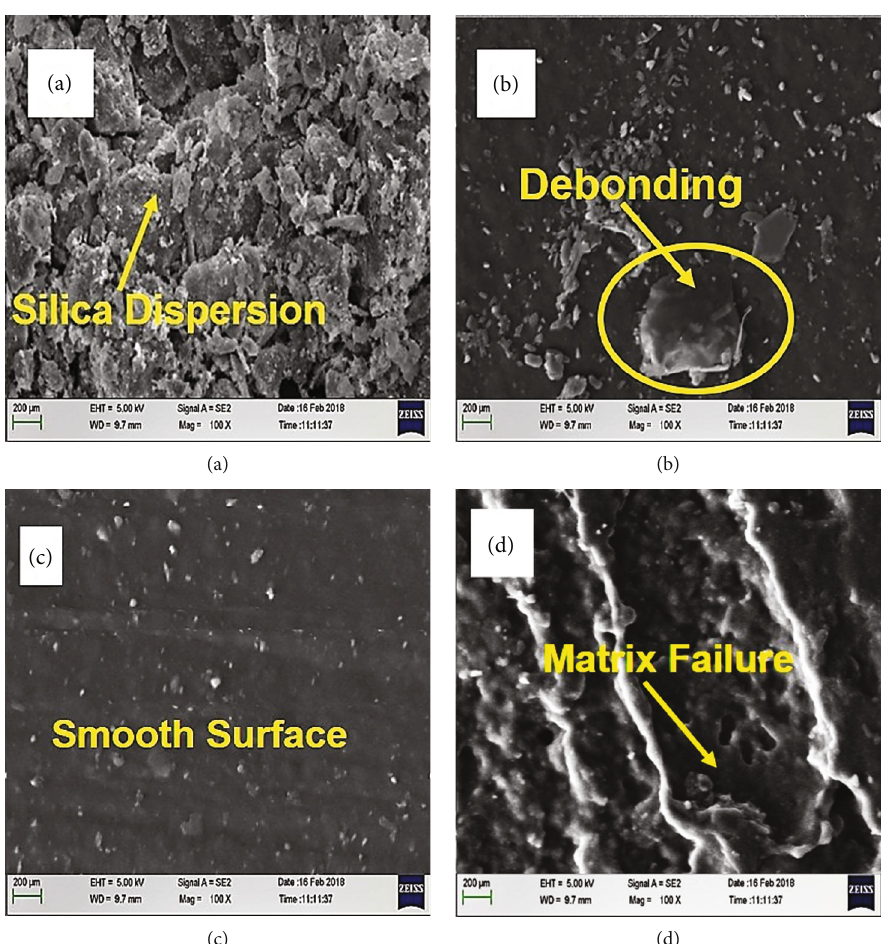
Figure 9: Microstructure images of (a) dispersion of nanosilica in epoxy, (b) 15 min cryogenic, (c) 30min cryogenic, and (d) 45 min cryogenic